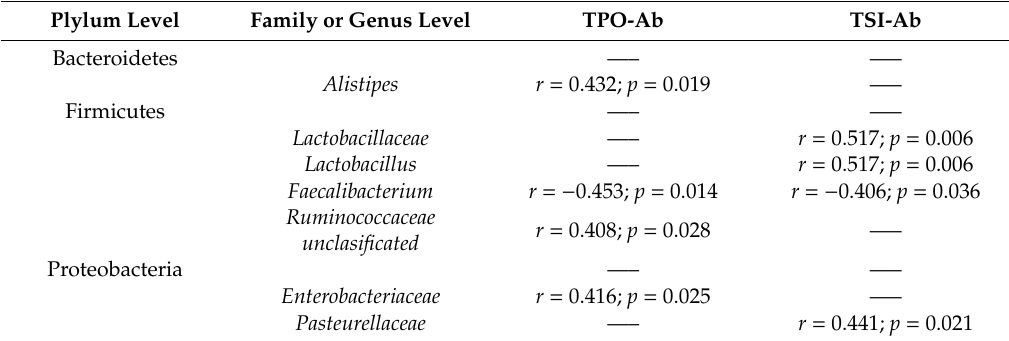
Table 2. Simple linear correlation relationship of autoimmunity and thyroid profile with gut microbiota (taxa abundances: samples at phylum, family, and genus levels).